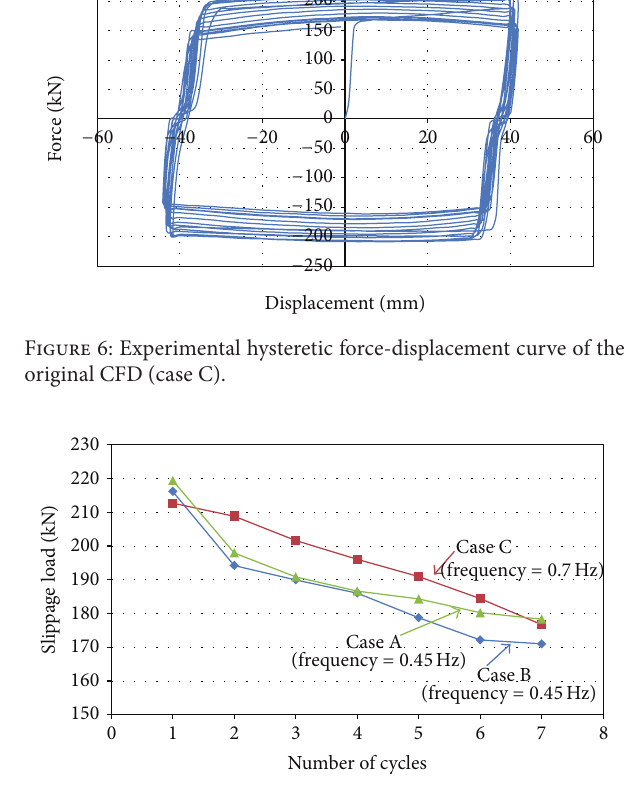
Figure 7: Slippage load versus number of